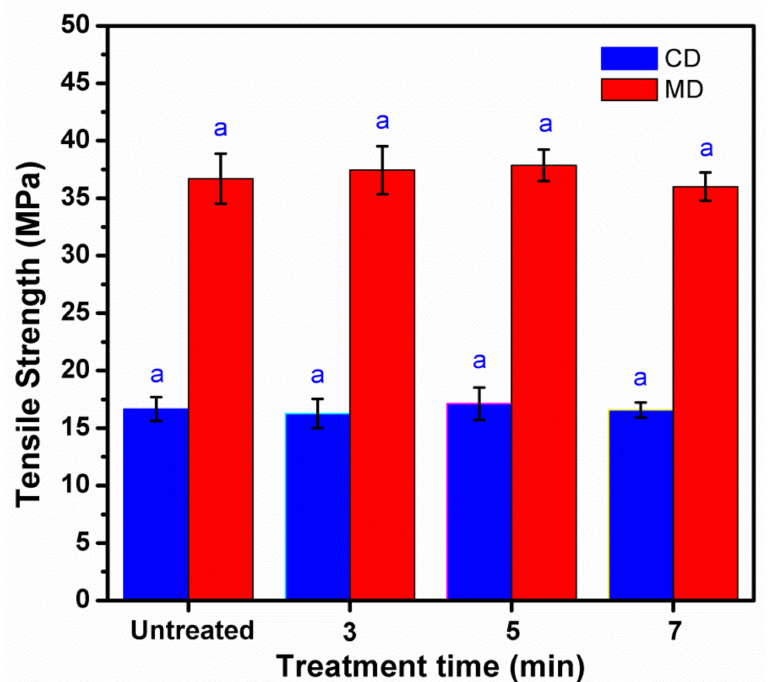
Figure 8. Effect of treatment time on tensile strength of untreated and treated KPs with plasma at 200 mTorr and 50 Watts (MD—machine direction, CD—cross direction). Note: values indicated with the same letters are not significantly different at p < 0.05.